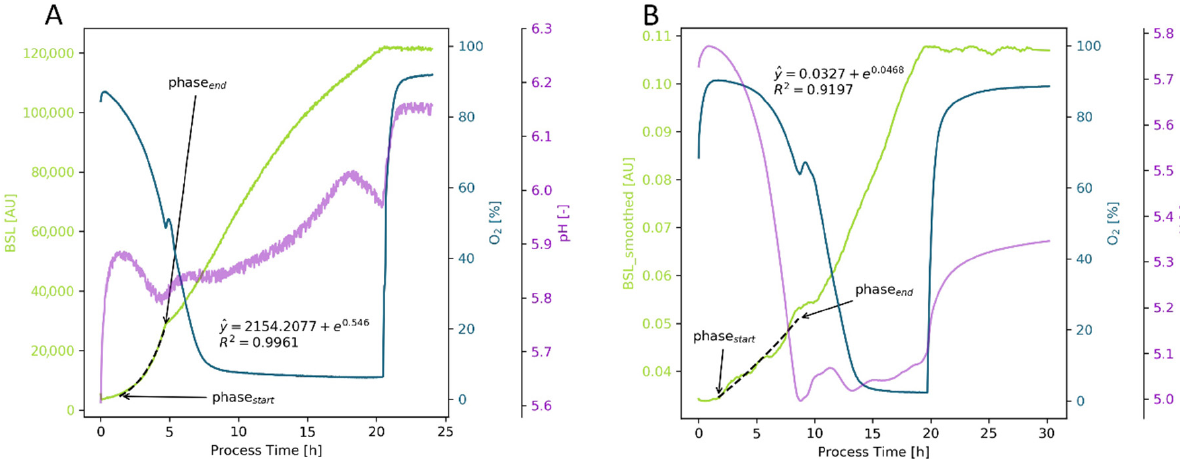
Figure 3. Cultivation of S. cerevisiae H1022 in YPD medium (250 mL unbaffled shake flask, 40 mL working volume, 180 rpm, 50 mm amplitude, 30 °C). The OUR curve (yellow) is used to determine the exponential growth phase, starting after a short (approx. 1.5 h) lag/adaption phase until shortly before the metabolic shift (5 h) from glucose consumption and ethanol formation to ethanol consumption. The estimated growth rate based on OUR during glucose consumption µ OUR, auto. was 0.445 h − 1 . Changes in metabolism are also visible as turning points in the pH curve (violet). Furthermore, oxygen limitation is visible by means of the constant OUR and O 2 (blue) curves between 8 and 21 h. The consumption of all C-sources (glucose and ethanol) and thus the end of the growth phase is visible in all signals at 21 h (rise of O 2 and pH, drop of OUR).